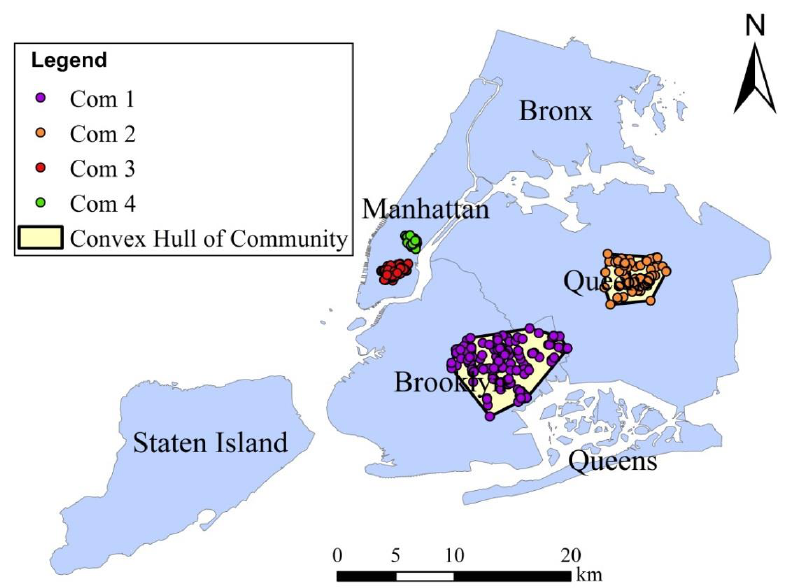
Figure 4. Typical communities detected by using the Walktrap algorithm. Table 2. Number of nodes and intra-community trips, and the most predominant link categories in the typical communities selected.